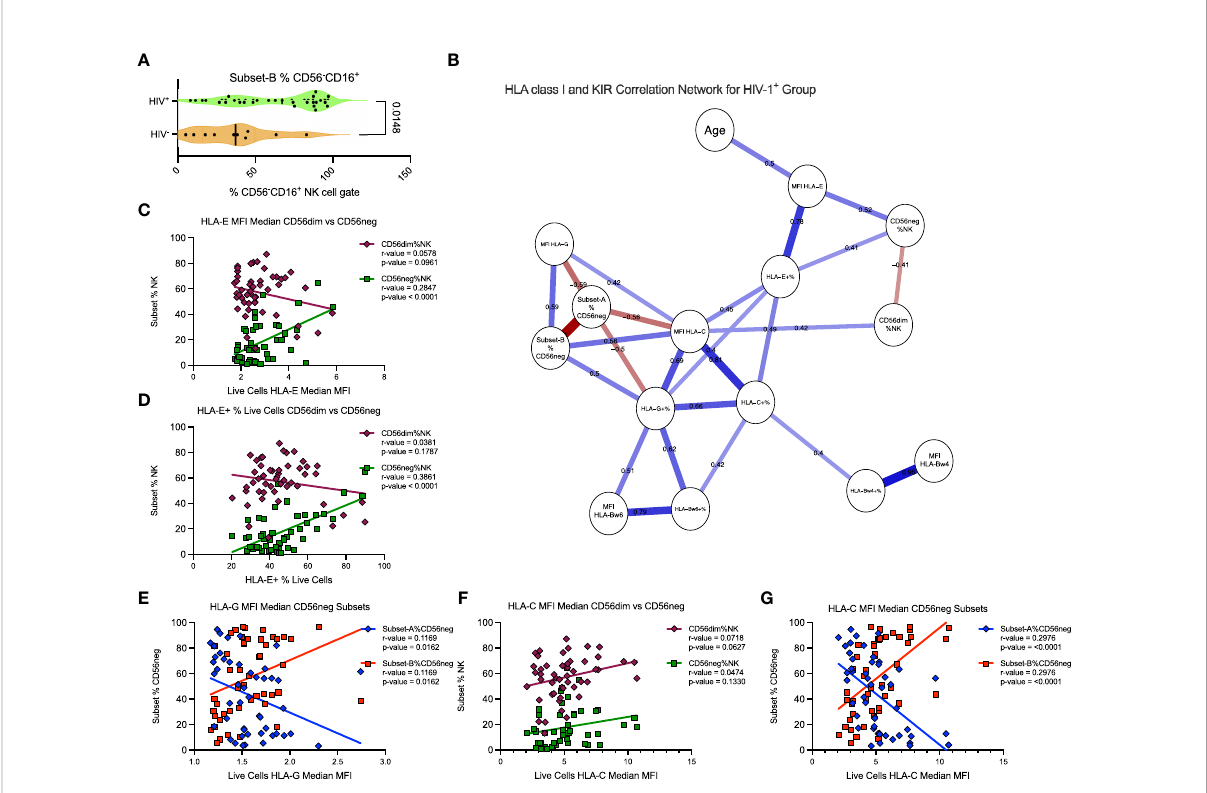
FIGURE 7 HLA-C expression associates with Subset-B frequency within CD56neg NK cells in HIV-1 + donors. (A) frequency of the Subset-B population within CD56neg NK cells, comparing HIV - and HIV-1 + donors (SDY1535) using two-tailed Mann-Whitney analysis. Median and IQR shown. (B) Spearman ’ s correlation network corrected using the FDR method, with signi fi cant (p < 0.05) relationships between the frequency and expression intensity of leukocyte HLA class-I molecules and the frequency of CD56neg and CD56dim subset within NK cells, and of Subset-A and -B frequencies within CD56neg cells of HIV-1 + donors (SDY1535). Blue lines show positive associations while red lines show inverse correlations, with correlation coef fi cients included above the lines. The plot was generated using qgraph (36). (C, D) show linear regression of CD56dim (maroon diamonds) and CD56neg (green squares) frequencies within NK cells to (C) HLA-E expression intensity on live cells, and (D) HLA-E expression frequency. (E) shows linear regression of Subset-A (blue diamonds) and Subset-B (red squares) frequencies within CD56neg NK cell gate with the median HLA-G expression intensity for the live cells from the same samples. (F, G) . show linear regression analysis of with HLA-C expression intensity on live cells, of (F) CD56dim and CD56neg cells, and (G) CD56neg Subset-A and -B